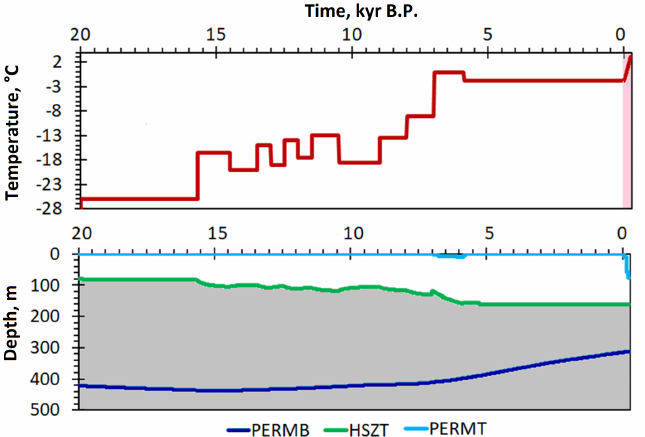
Figure 2. The results of numerical simulation based on the heat transfer model. The upper panel shows the paleotemperature scenario for the period 20 thousand years ago–1950 and 1950–2200 (highlighted in pink). At the bottom—the evolution of the permafrost and methane hydrate stability zone over the past 20 thousand years: the lower boundary of the permafrost (PERMB) is the blue line, the upper boundary of the permafrost (PERMT) is the blue line, and the upper boundary of the methane hydrate stability zone (HSZT) is the green line. The area of possible hydrate existence is highlighted in gray.